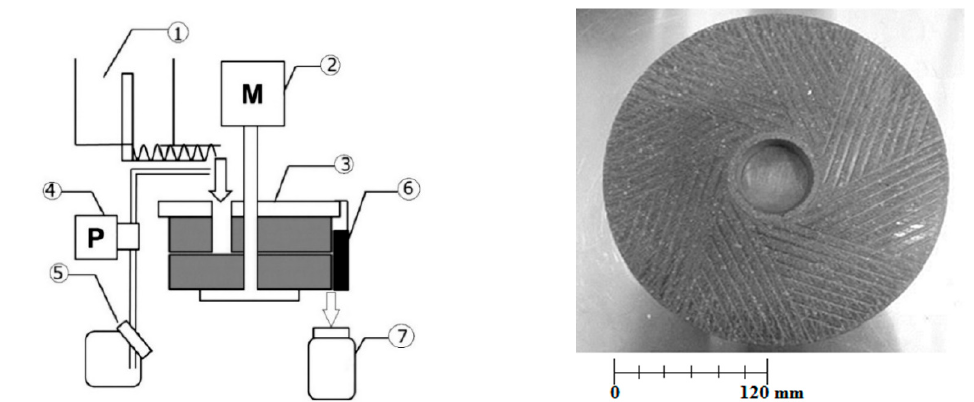
Figure 1. Schematic diagram of the micro wet milling system. (1) Rotary rice feeding equipment, (2) Motor, (3) Milling stone, (4) Tubing pump, (5) Water tank, (6) Rubber Spatula, (7) Receiver. Picture of the lower stone of mill [14].